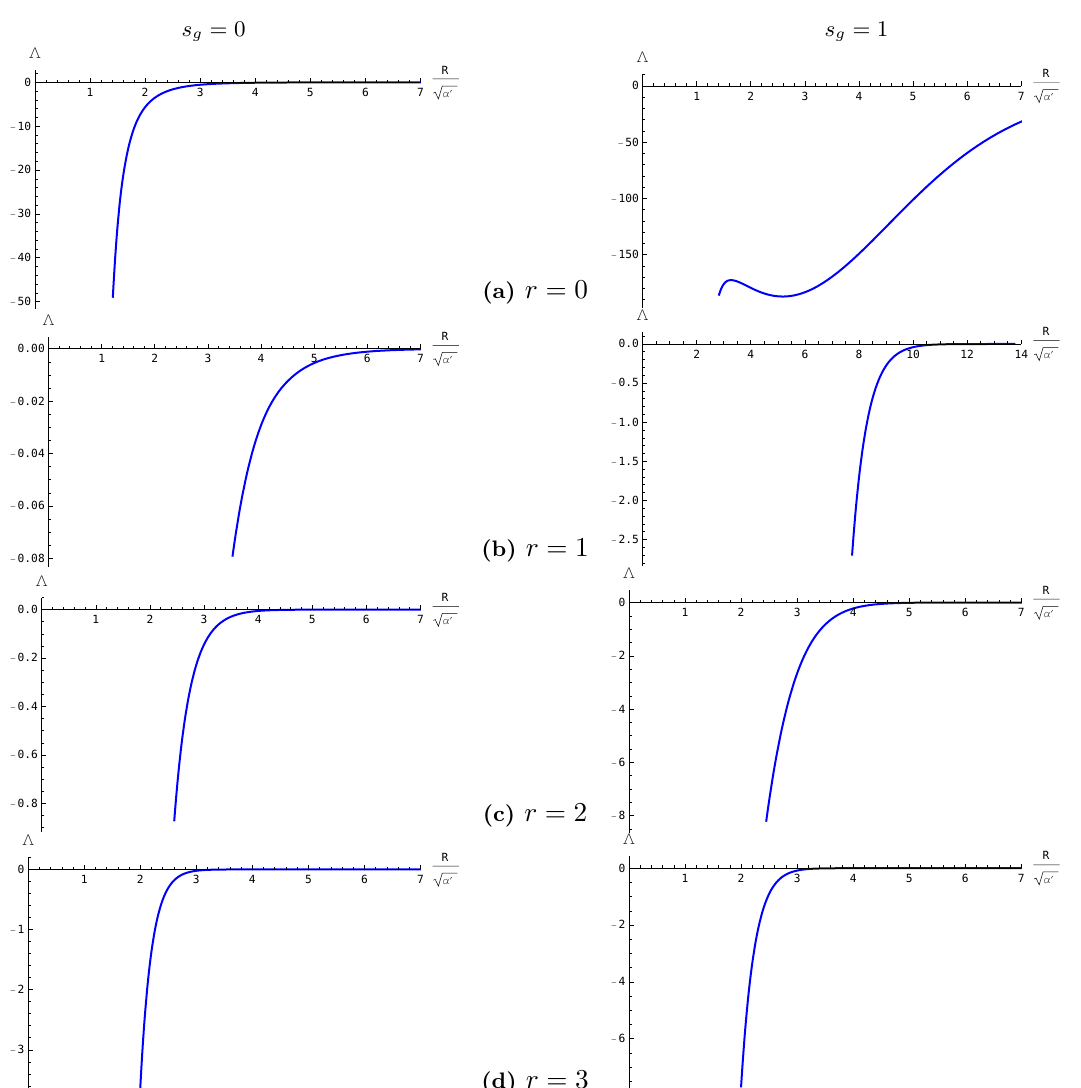
Figure 5. Contribution from g r -twisted sectors to 1-loop Λ in class I Z 6 models with s g = 0 , 1 .